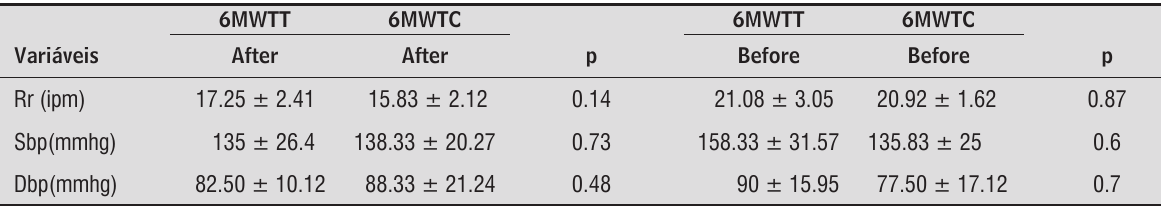
Table 1 - Mean and standard deviation of respiratory rate (RR), systolic blood pressure (SBP) and diastolic blood pressure (DBP) in 24 cardiac patients submitted to the six minute walking test in the treadmill (6MWTT) and in the corridor (6MWTC)